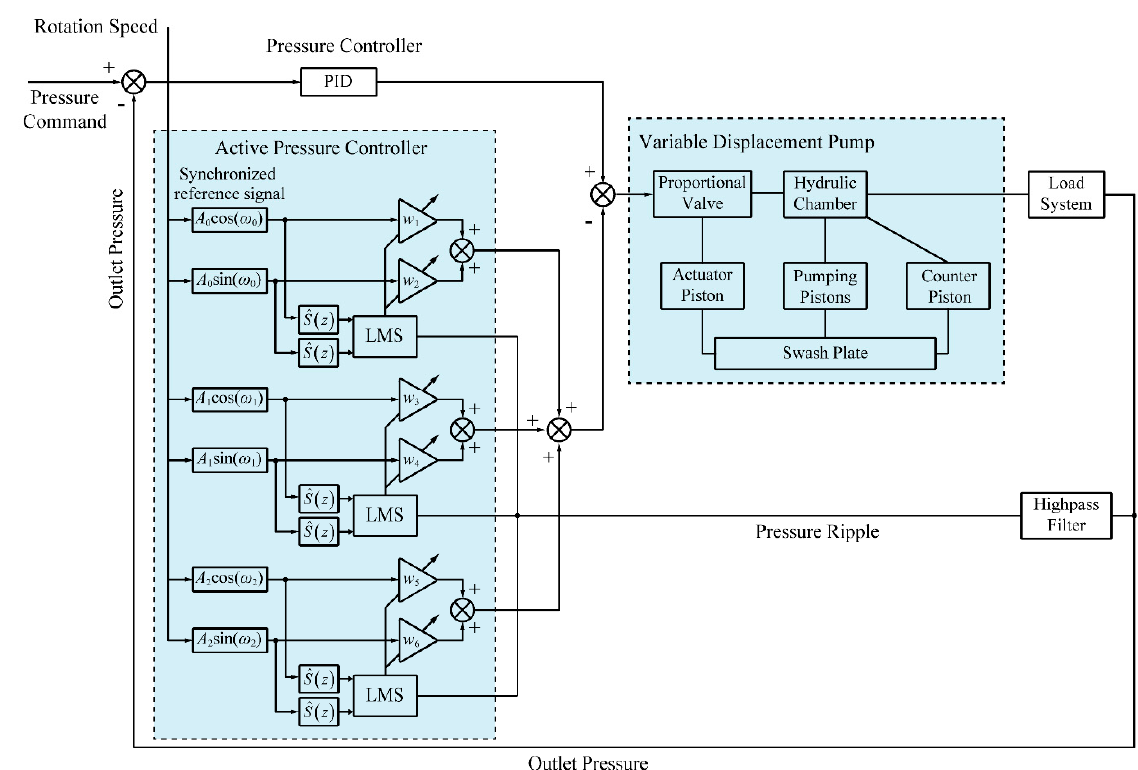
Figure 6. Block diagram of active pressure ripple control system.